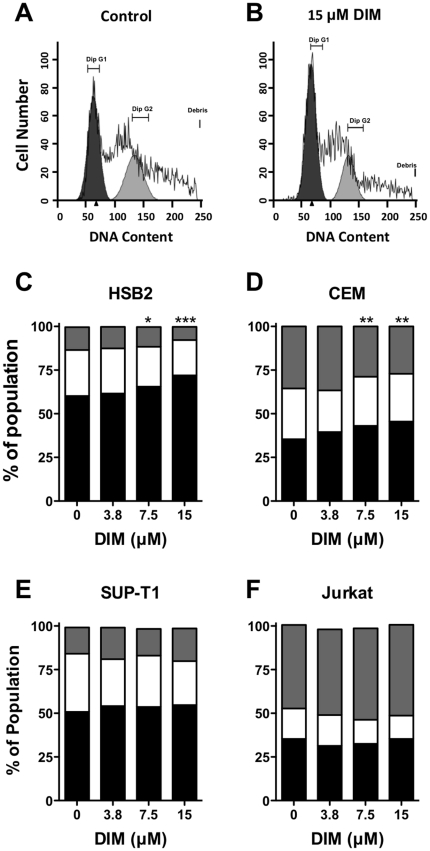
DIM induces cell-cycle arrest in CEM and HSB2 cells.Cells were treated with 0, 3.8, 7.5, or 15 µM DIM for 48 hr, then fixed in ice-cold 70% EtOH and stained with propidium iodide. DNA content distribution was analyzed by Guava PCA or Accuri C6 flow cytometry. (A–B) Representative histograms are shown for control and 15 µM DIM treatments at 48 hr in human CEM cells. (C–D) Distributions of CEM, HSB2, SUP-T1 or Jurkat cells in G1 (black), S (white), and G2 (grey) phases of cell-cycle progression at 48 hr (n = 3 to 5 independent experiments). *, p<0.05; **, p<0.01 or *** p<0.001 for G1 arrest compared to the vehicle control (0.1% DMSO) as determined by one-way RM ANOVA (matching by experiment day) with Dunnett's multiple comparisons post-hoc test.